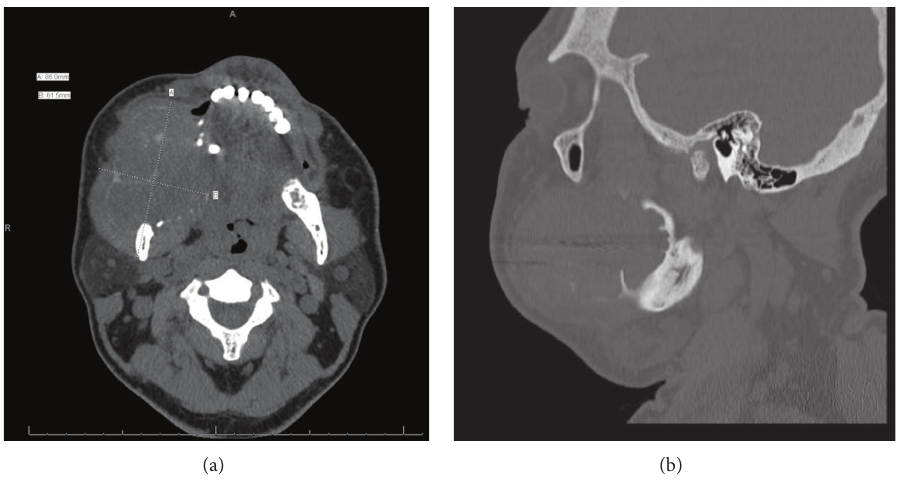
Figure 2: (a) Axial CT image. (b) CT scan, sagittal view.